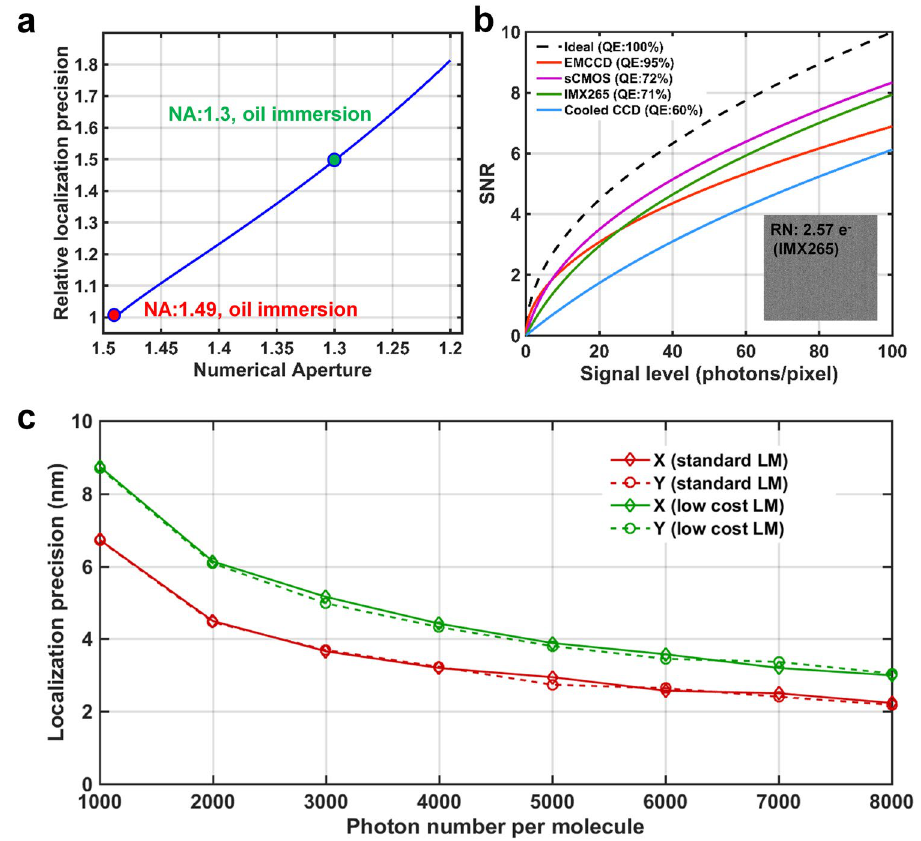
Figure 3. Comparison of localization performance by theoretical calculation and numerical simulation. ( a ) Comparison of relative localization precision for the objectives with different NAs. ( b ) Comparison of localization precision for different cameras under different signal levels. ( c ) Comparison of localization precision between the low-cost SMLM and the standard SMLM under different signal levels using simulated images. 1000 images were simulated for each data point. Here, the standard SMLM uses TIRF objective (100X, NA1.49) and EMCCD camera with a pixel size of 160